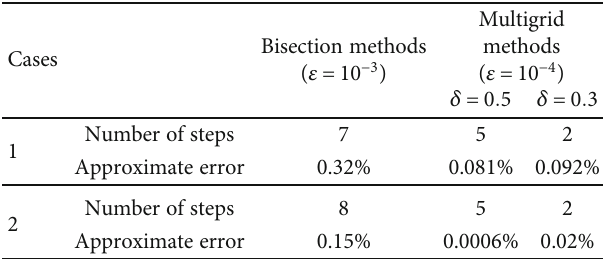
Table 7: Comparison of number of iterations and error in cases of using the multigrid and bisection methods with a given precision of ε